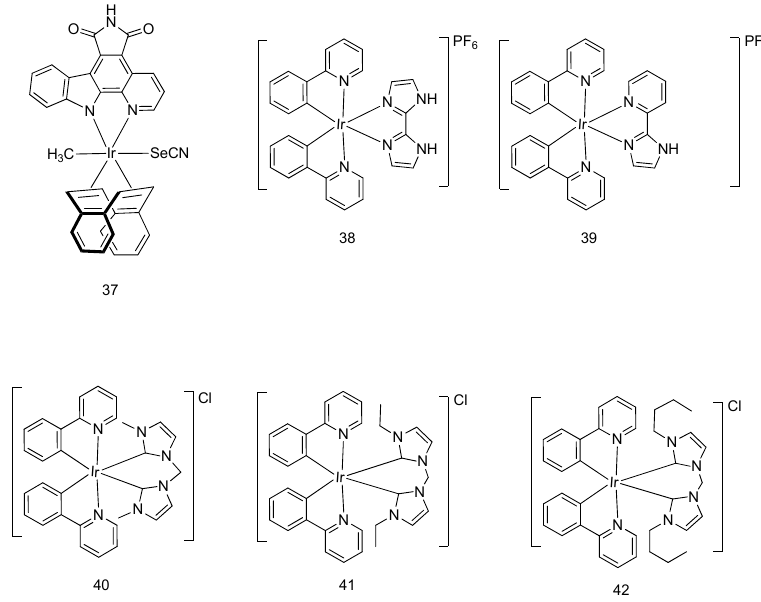
Figure 11 . Diverse cyclometalated octahedral iridium(III) compounds. Figure 11. Diverse cyclometalated octahedral iridium(III)